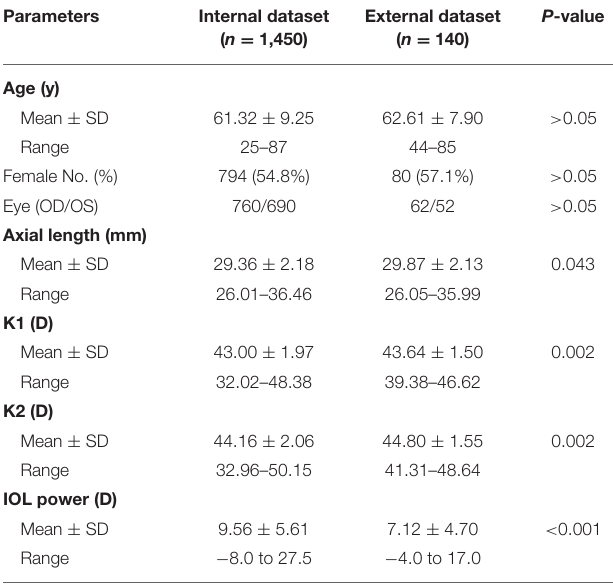
TABLE 1 | Demographics of the internal and external